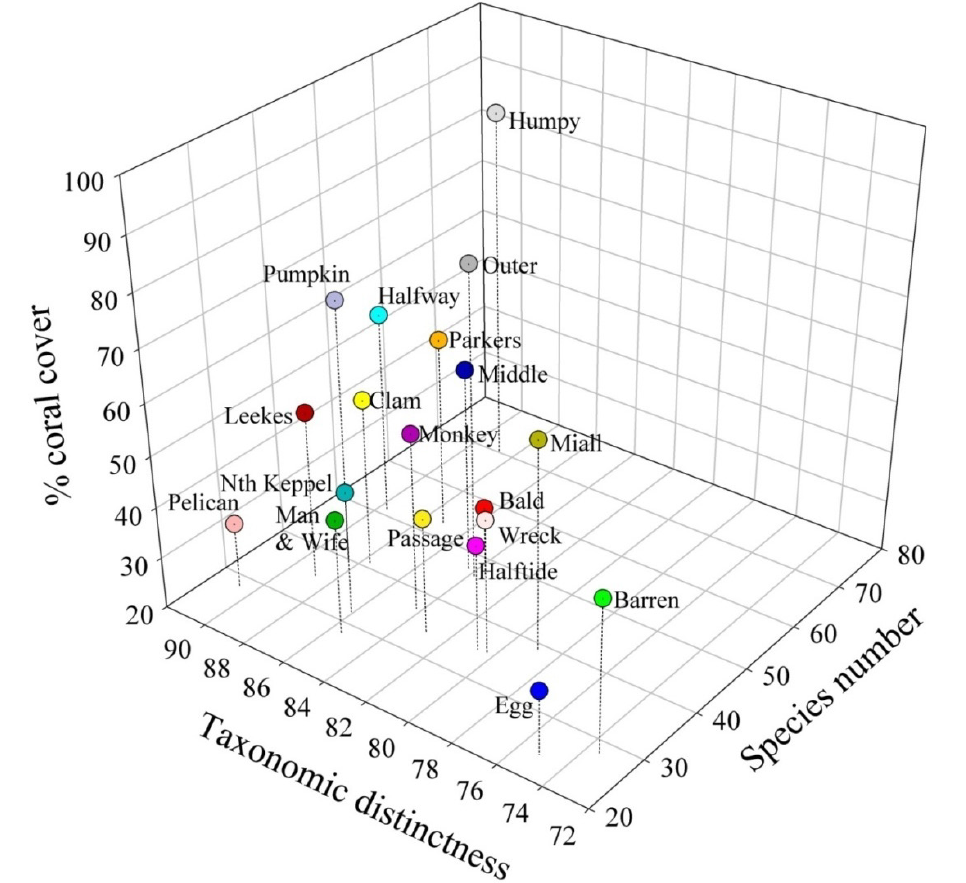
Figure 7. 3-D plot of species richness, taxonomic distinctiveness and coral cover for the 19